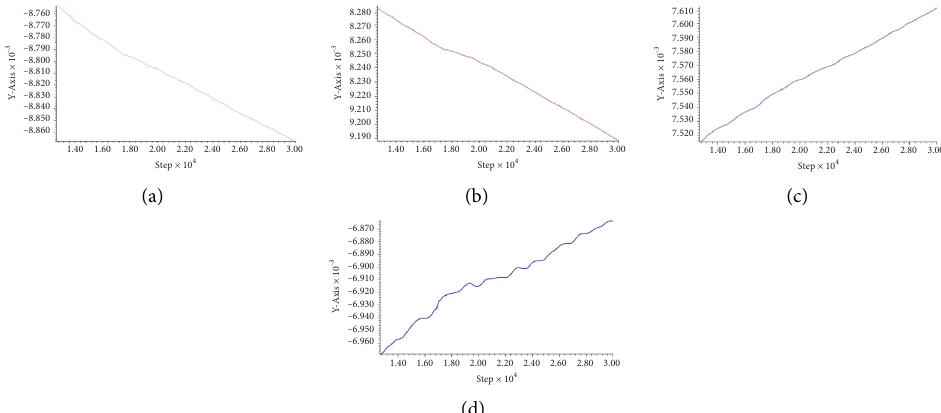
Figure 15: Deformation of surrounding rock when first excavated roadway without support: (a) roof, (b) floor, (c) left side, and (d) right